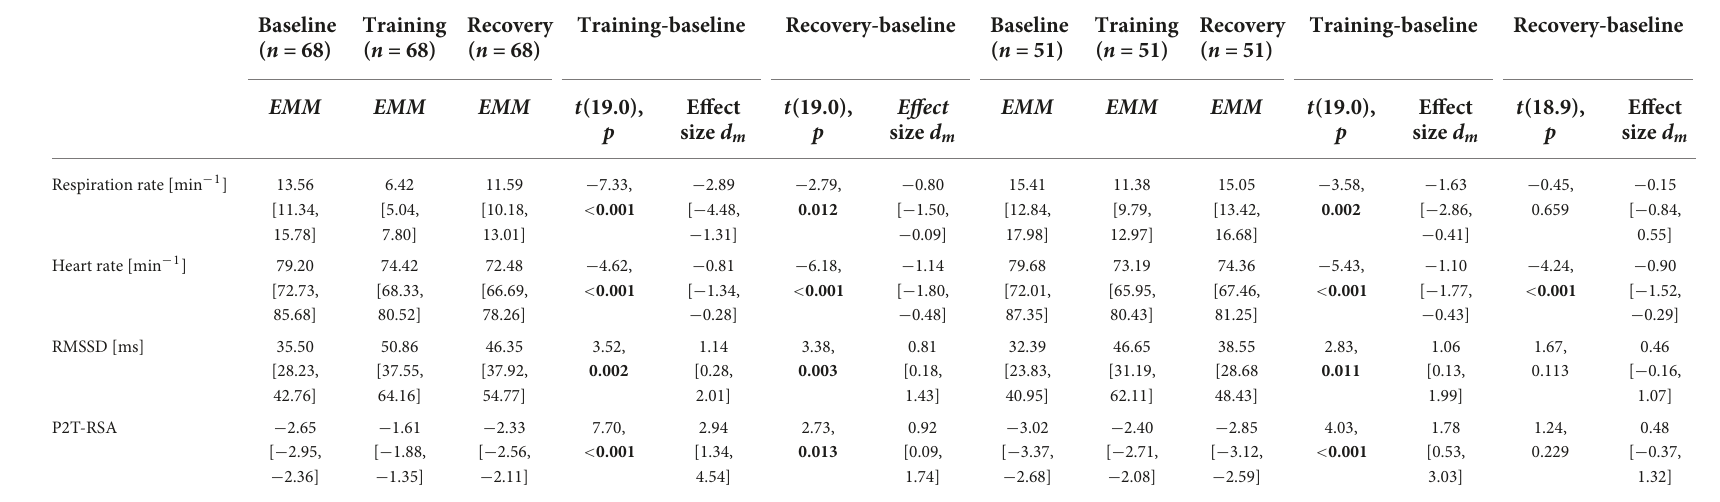
Physiologicalmeasuresrecordedduringtrainingwerecomparedwithmeasuresoftherestingstatebefore(baseline)and5minaftertraining(recovery)usingrobustlinearmixed-effectmodels.The95%CIsandmeasurementunits,ifpresent,arepresented insquarebrackets. P -valuesbelow0.05aredisplayedinboldfont.Theresultsshowthattrainingstimulatedcardiacvagalcontrolinbothgroups.Effectsweregreaterwhenbiofeedbackwasusedandevenpersistedafterthetraining.CI,confidenceinterval; d m ,effectsizecalculatedbythe emmeansR packageanalogoustoCohen’s d ; EMM ,estimatedmarginalmean;RMSSD,rootmeansquareofsuccessiveheartbeatintervaldifferences;P2T-RSA,naturallogarithmoftherespiratorysinusarrhythmiacalculated